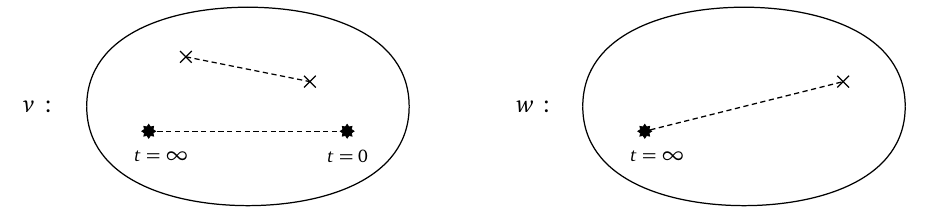
Figure 3: The figure displays the sheet structures of v -curve and w -curve over the Gaiotto curve C with the coordinate t . A star denotes a singular point where the corresponding curve escapes to infinity, × denotes a non-singular branch-point, and the dashed lines denote branch